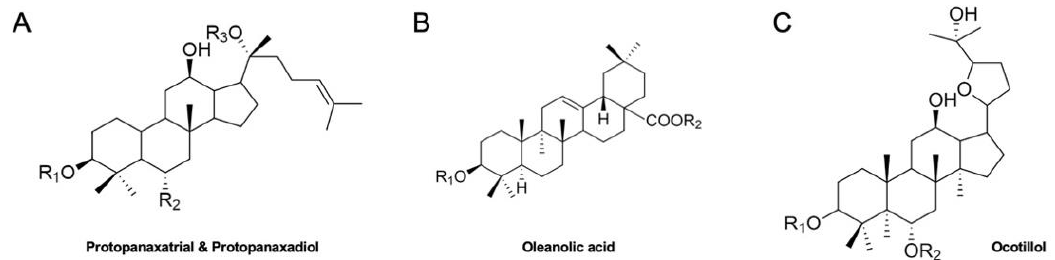
Figure 1. Backbone structures of ginsenosides. ( A ). Chemical structures of protopanaxatrial and protopanaxadiol, ( B ). Chemical structure of oleanolic acid, ( C ). Chemical structure of ocotillol.